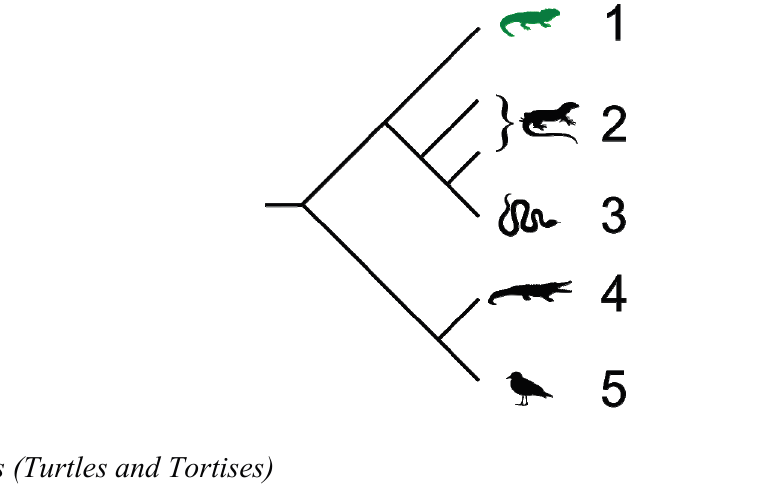
Figure 1. Cladogram showing the relationships of extant members of the Sauria (Sauropsida) which includes birds and reptiles. Branch lengths are not representative of divergence time. 1. Tuataras; 2. Lizards; 3. Snakes; 4. Crocodiles; 5. Birds. Cladogram by Benchill, licensed under the Creative Commons Attribution 3.0 Unported license [24].